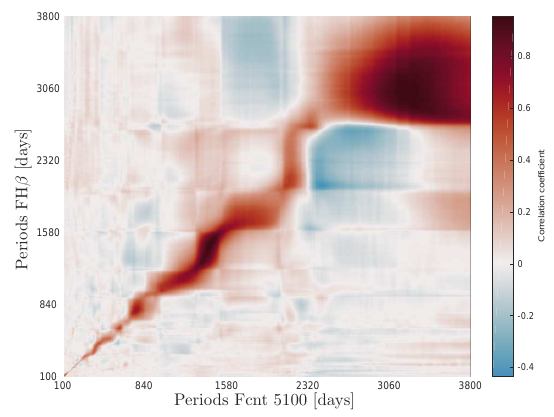
Figure 5. The same as Figure 4 but for continuum and H β emission line of NGC 3516. Detected period is 1385 ± 128